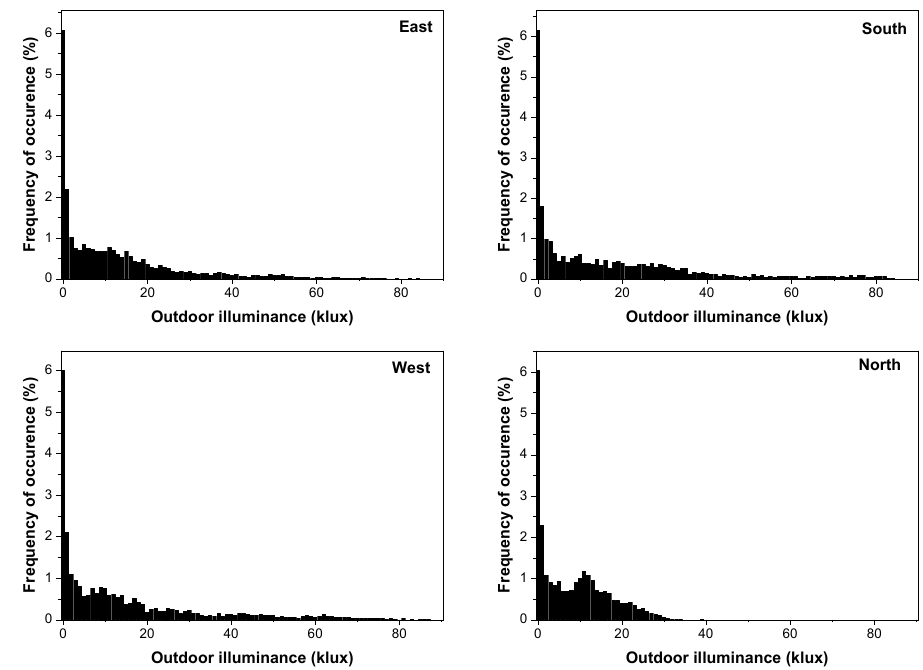
Figure 10. Frequency of occurrence of vertical global outdoor illuminance.